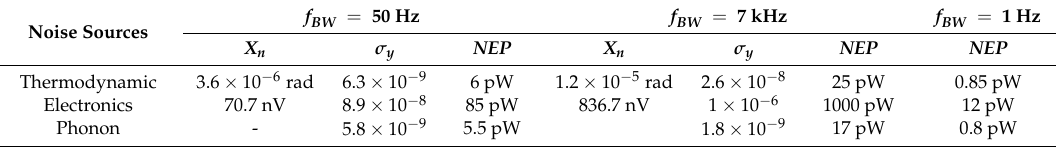
Table 4. Theoretical frequency stability and NEP for the nominal pixel with our electronics and 2 f -down-mixing readout scheme: R f = 1050 /W, θ C = 13.5 ◦ , V n = 10 nV/ V out = 320 µ